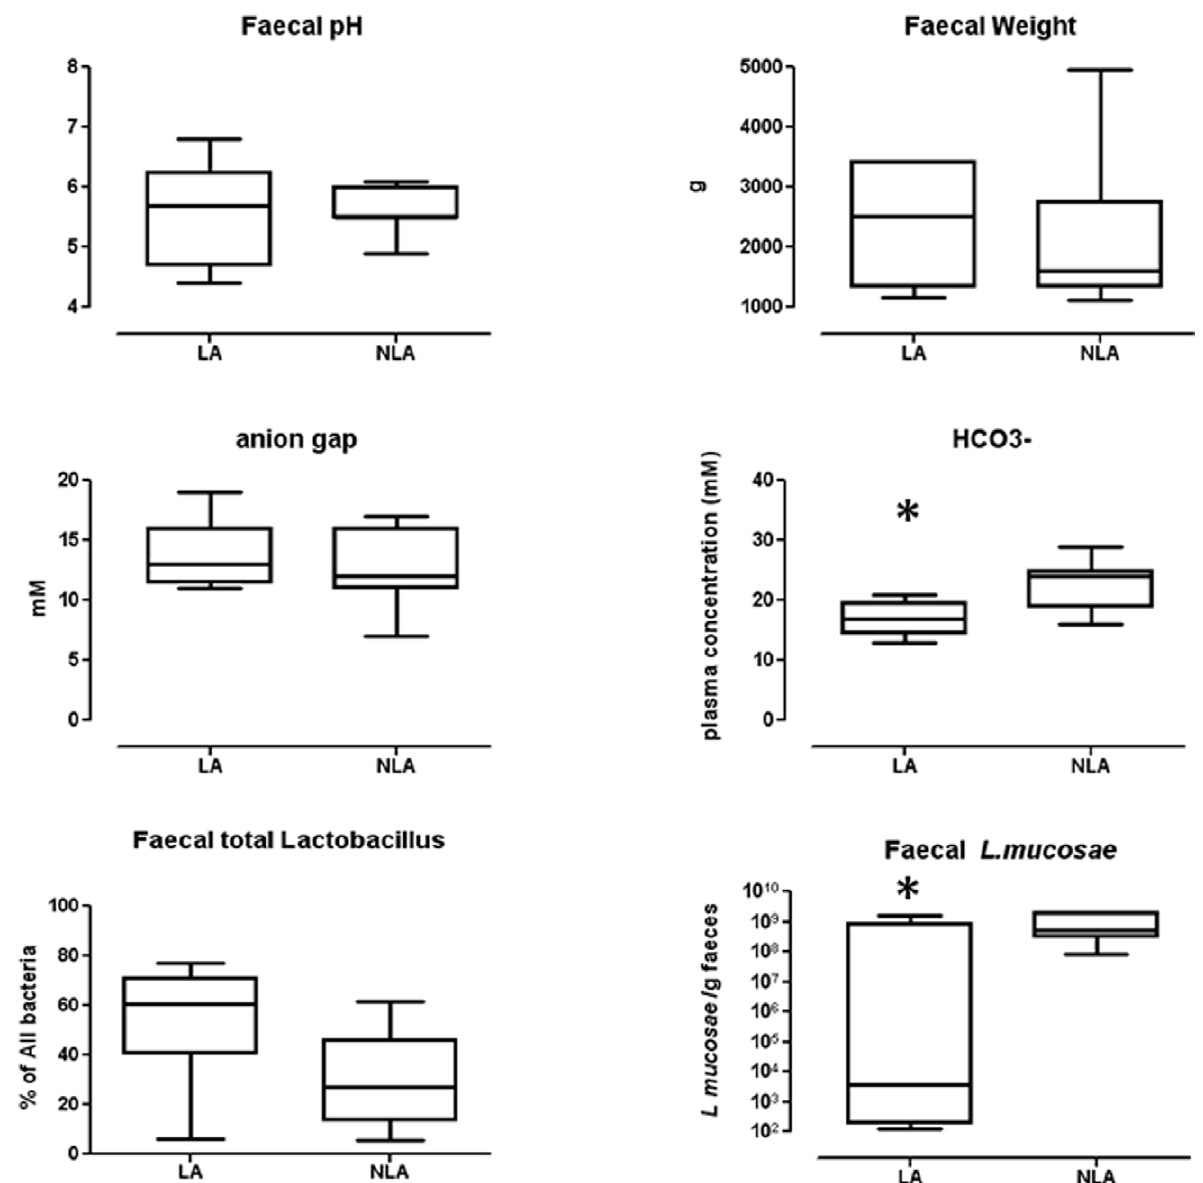
Figure 3. Different faecal and plasma parameters that characterize the lactate-accumulator group (LA) and the non-lactate accumulator group (NLA) of SBS patients. * p , 0.05. Faecal total Lactobacillus was expressed in % of all bacteria. Faecal weight was expressed in g/24 h. Faecal L. mucosae was expressed as bacterial cell/g faeces. Plasma parameters: HCO3 2 and anion gap were expressed in mM.